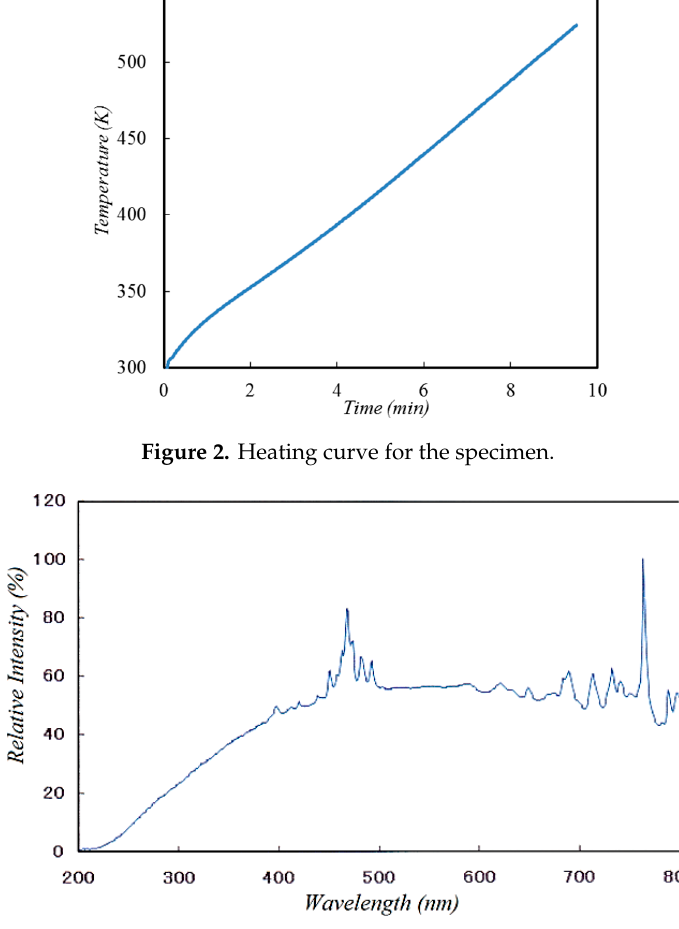
Figure 3. Emission spectra of F -light source (xenon lamp).